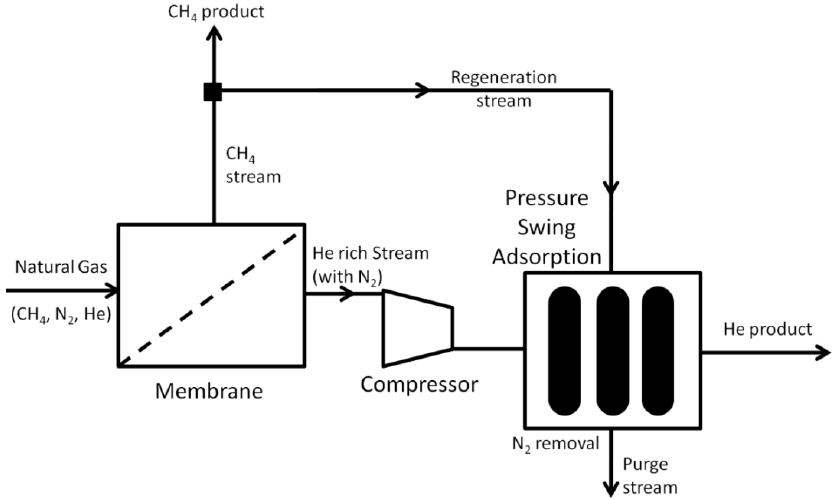
Figure 3. Process combining membrane separation with pressure swing adsorption (PSA) for the recovery and purification of helium.